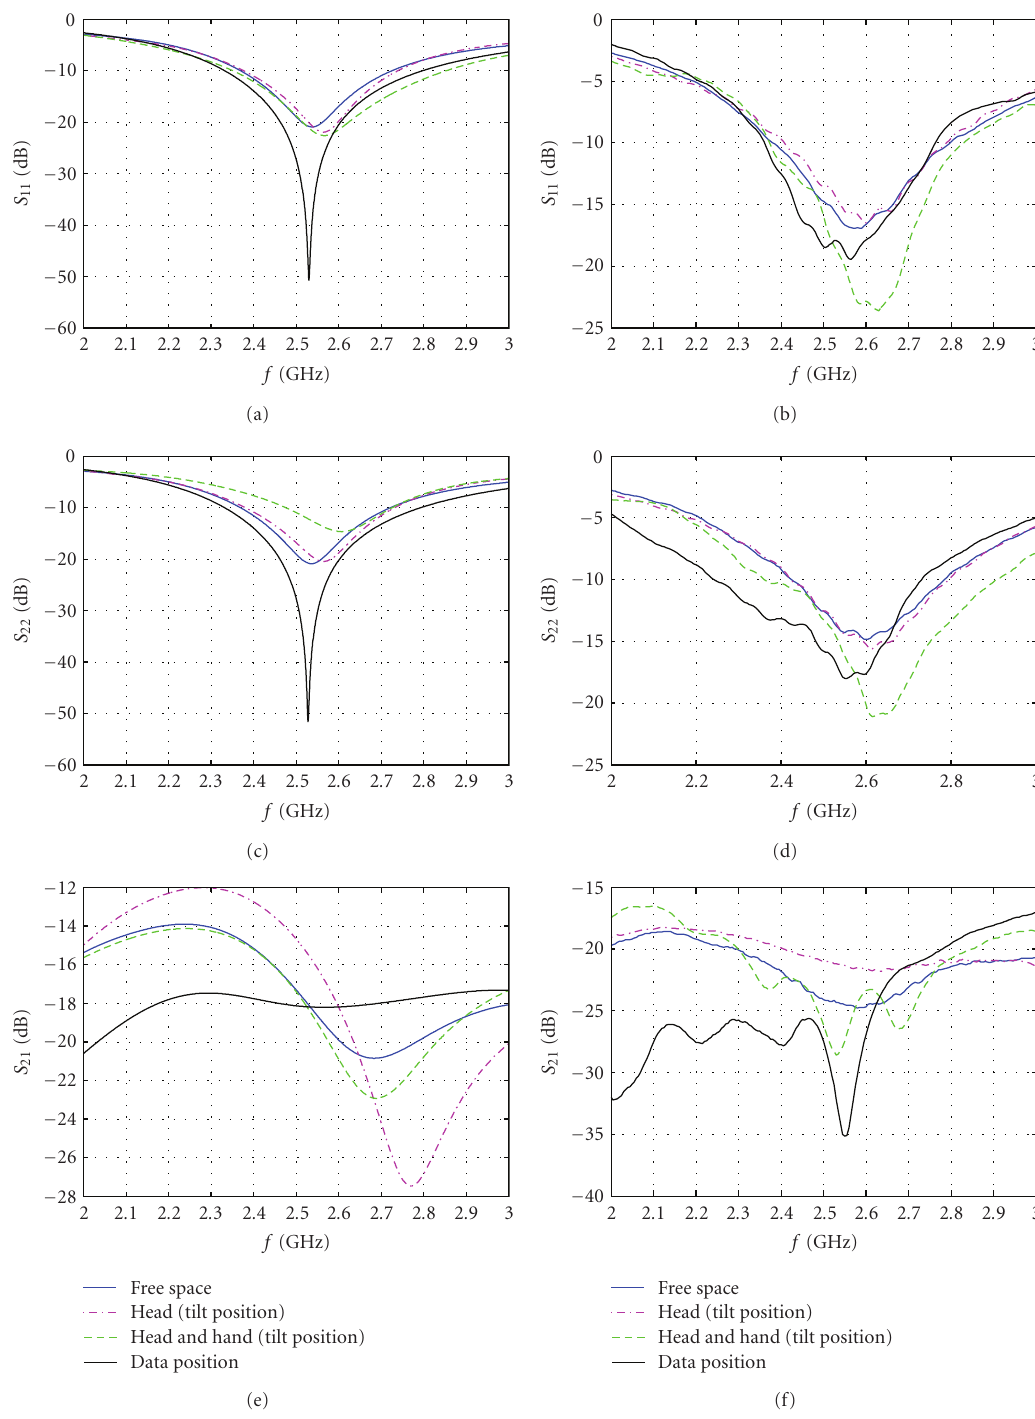
Figure 4: S -parameters for PIFA design (a) simulated S 11 , (b) measured S 11 , (c) simulated S 22 , (d) measured S 22 , (e) simulated S 21 , (f) measured S 21